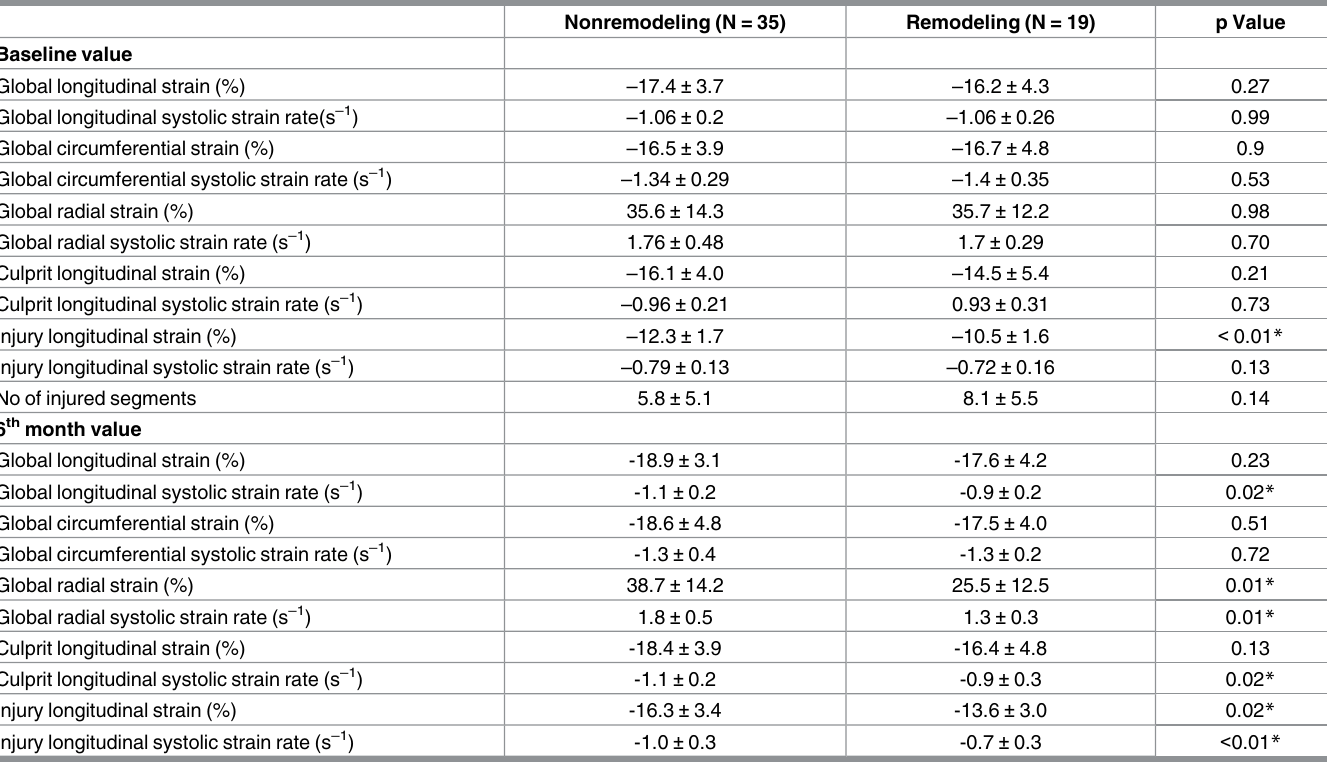
Table 7. Left ventricle deformation performance indices in STEMI